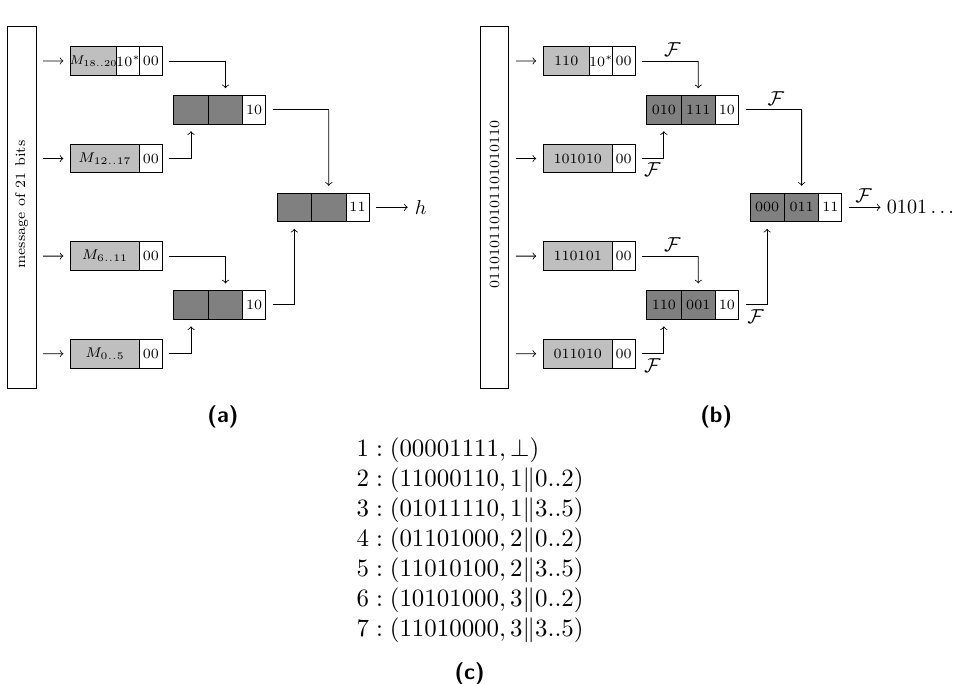
Figure 1: (a) Schematic example of a tree template Z , (b) its corresponding instantiation S for a specific input message M , and (c) its corresponding list of couples. For figures (a) and (b): white blocks contain frame bits, light gray blocks contain message pointer bits, and dark gray chaining blocks contain chaining pointer bits. For figure (c): “(11000110 , 1 k 0 .. 2)” means that the evaluation of F on 11000110 is represented by bits 0 .. 2 of line